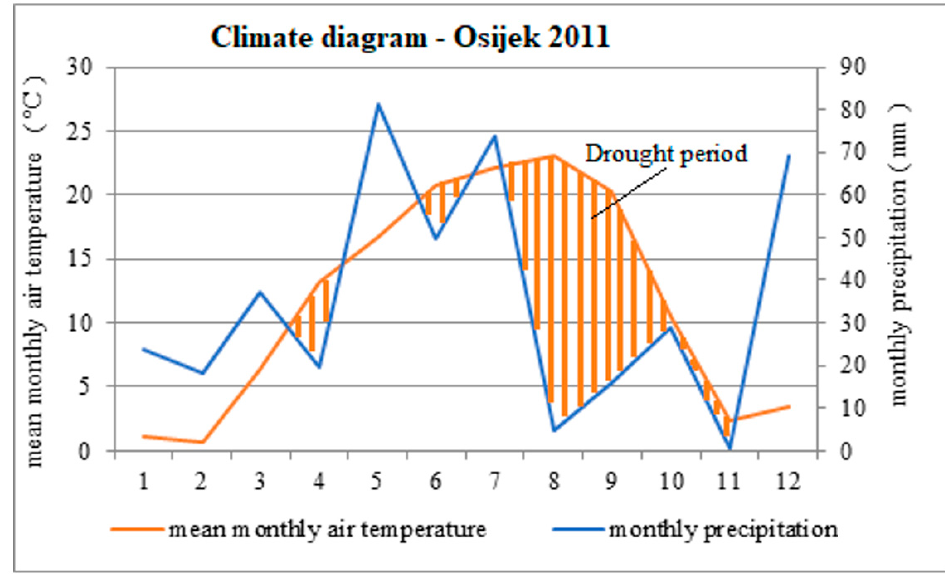
Figure 8. Climate diagram for Osijek, Croatia for the year 2011.